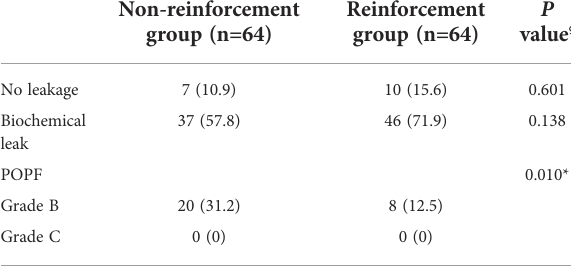
TABLE 3 Comparison of rate of postoperative pancreatic fi stula in staple line reinforcement and non-reinforcement groups .